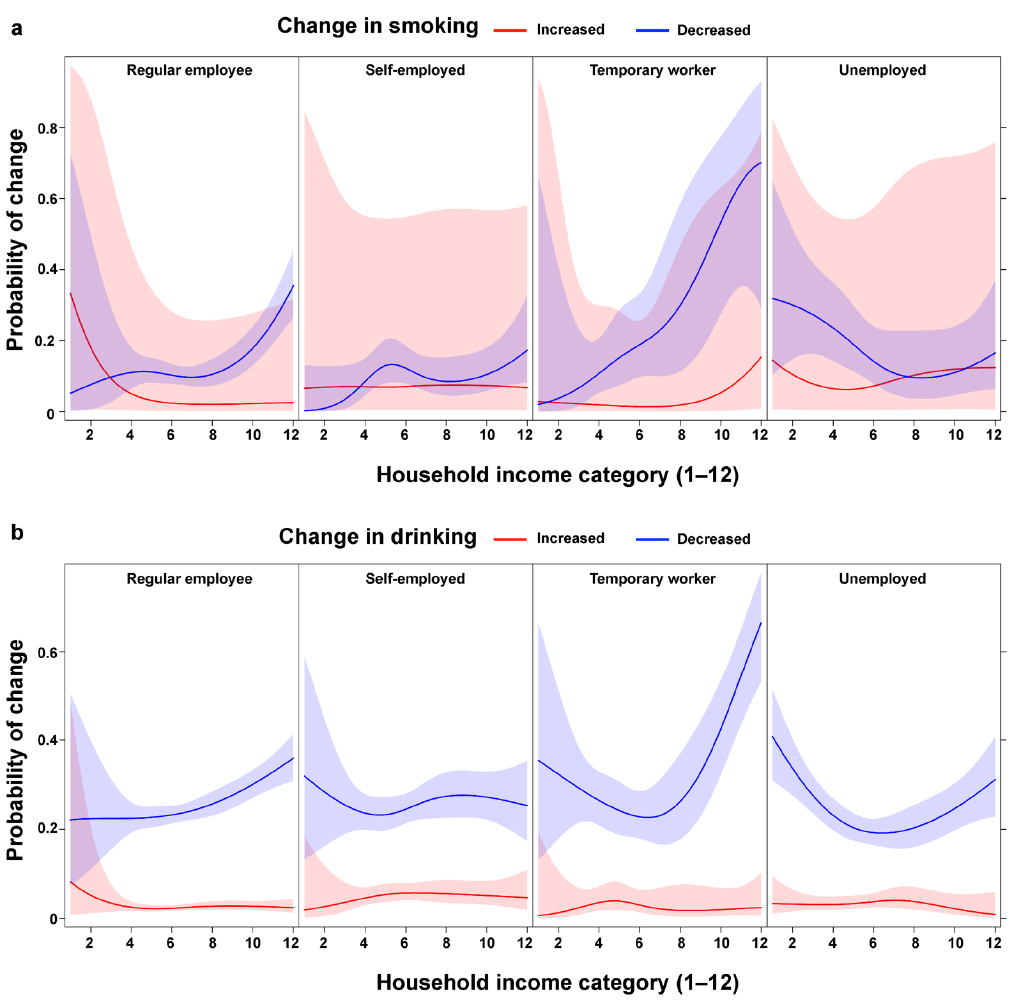
Figure 4. Probability of changes in ( a ) smoking and ( b ) drinking by household income within employment statuses. The interaction terms are statistically significant for both smoking changes χ 2 (df = 18) = 51.5, p < 0.001) and drinking changes ( 𝜒 (cid:2870) (df = 18) = 33.9, p = 0.013).